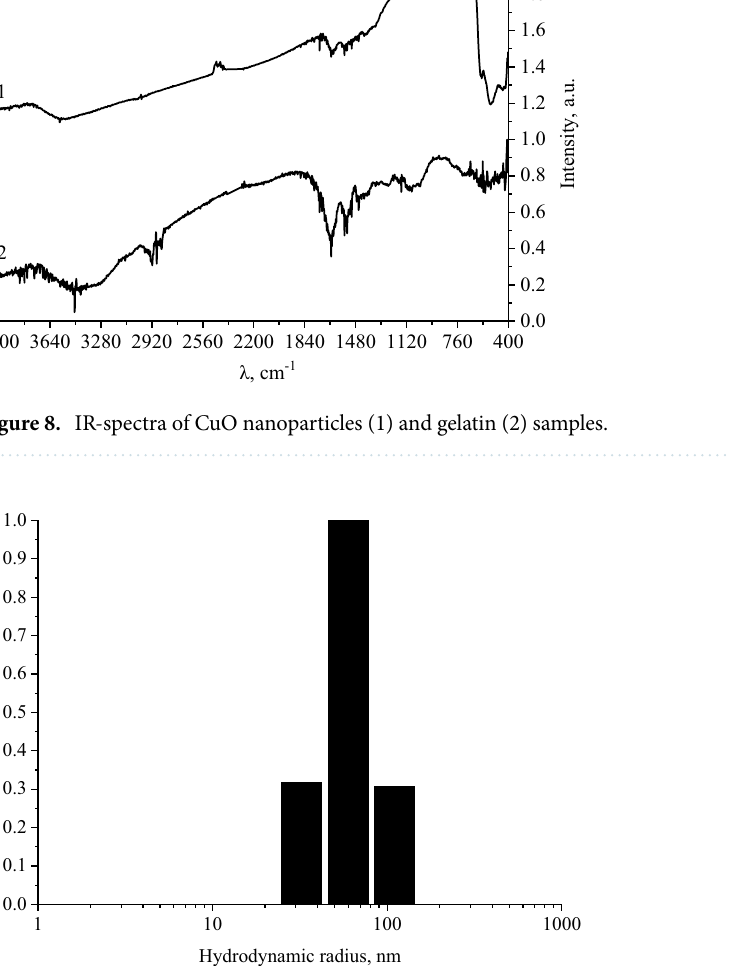
Figure 9. CuO nanoparticles’ hydrodynamic radii distribution in the sol diluted 64 times with distilled water.